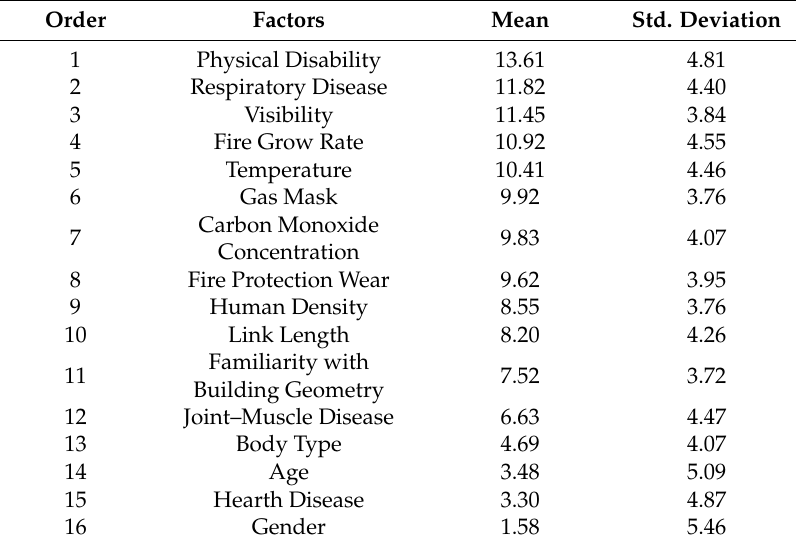
Table 3. Mean and standard deviation values for all the